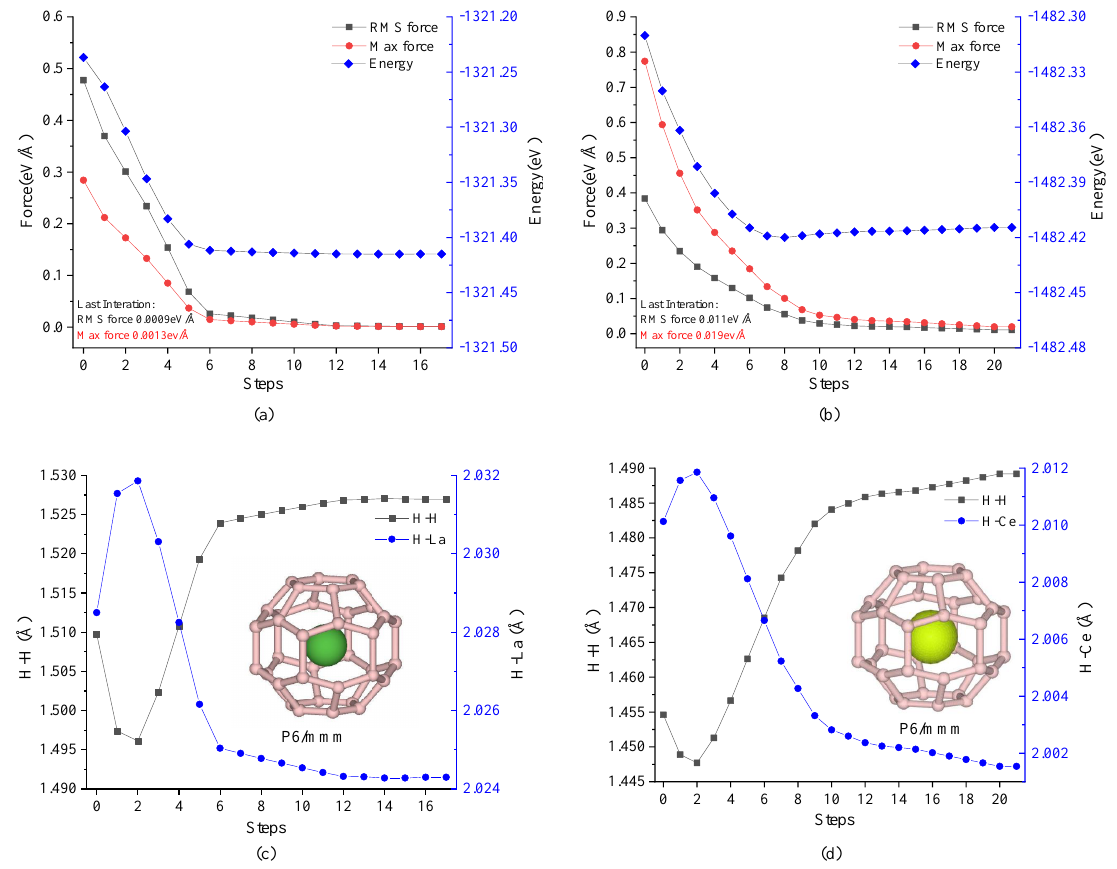
Figure 2. Structural relaxation of clathrate lanthanides with many-body corrections. We report the structural relaxation of the LaH 16 ( a , c ) and prototype CeH 16 ( b , d ) compounds. All calcu- lations are performed at 250 GPa. The volume density is obtained by the equation of state in DFT+DMFT+CSC that provides very similar results to PBE (not shown). Internal coordinates are relaxed with DFT+DMFT+CSC, building upon the recent implementation of DFT forces for ultra-soft pseudo-potentials. We report the forces and total energies obtained during the structural optimisation, respectively, in ( a , b ) for LaH 16 (CeH 16 ). Convergence is obtained within 25 iterations. The shortest H–H and Ce–H bond lengths increase throughout the structural optimisation (see c , d for La and Ce hydrides,